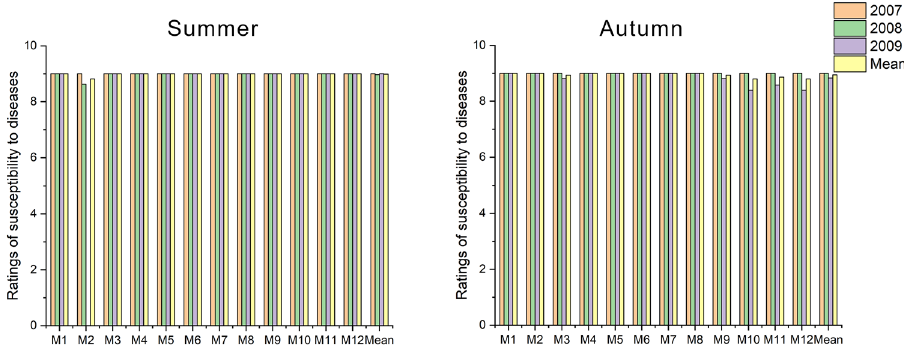
Figure 5. Ratings of susceptibility to diseases across grass mixtures and research years.